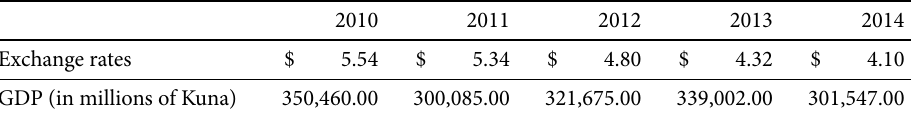
table 3. Dollar exchange rate depreciation impact on GDp